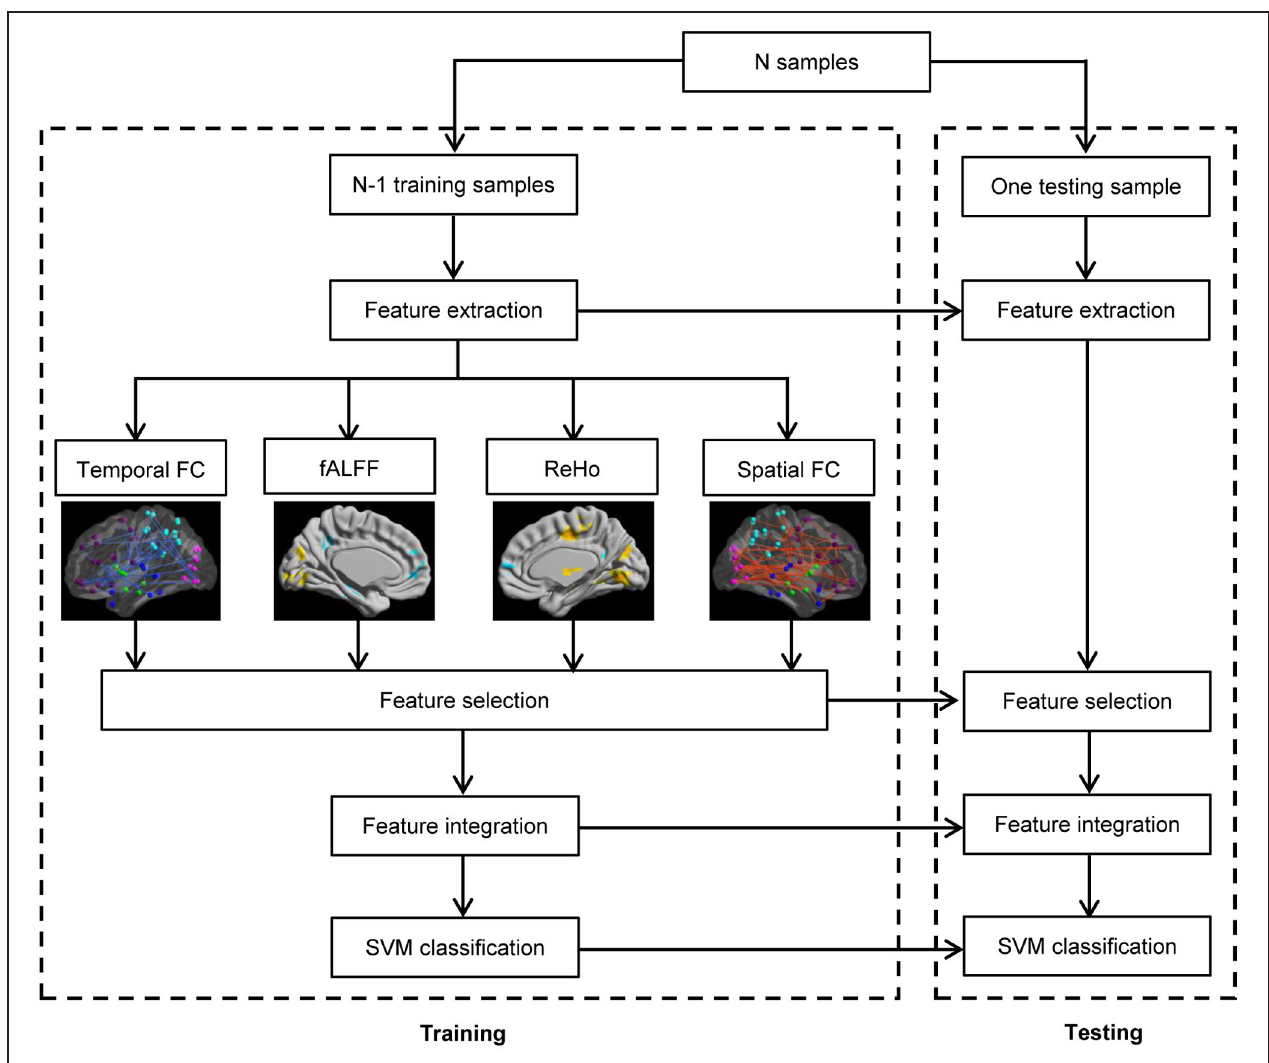
FIGURE 1 | Flowchart of the pattern recognition framework proposed.